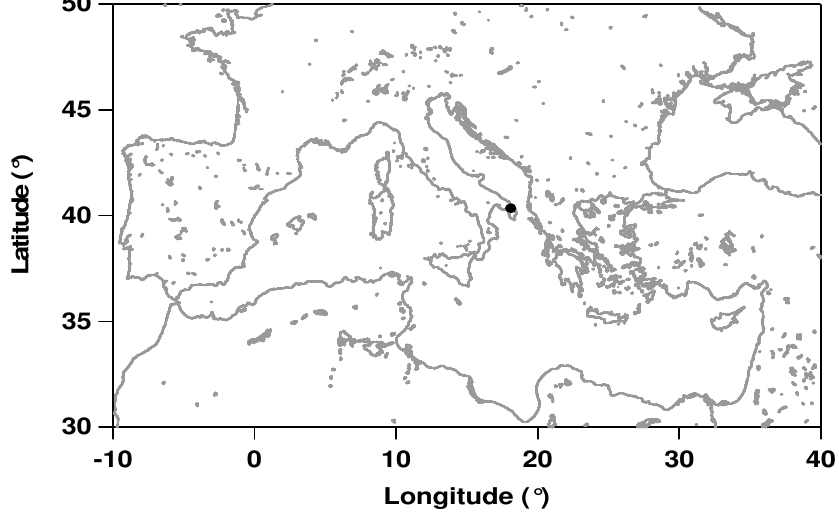
Figure 1. The geographical location of the study area (black dot) in the Mediterranean